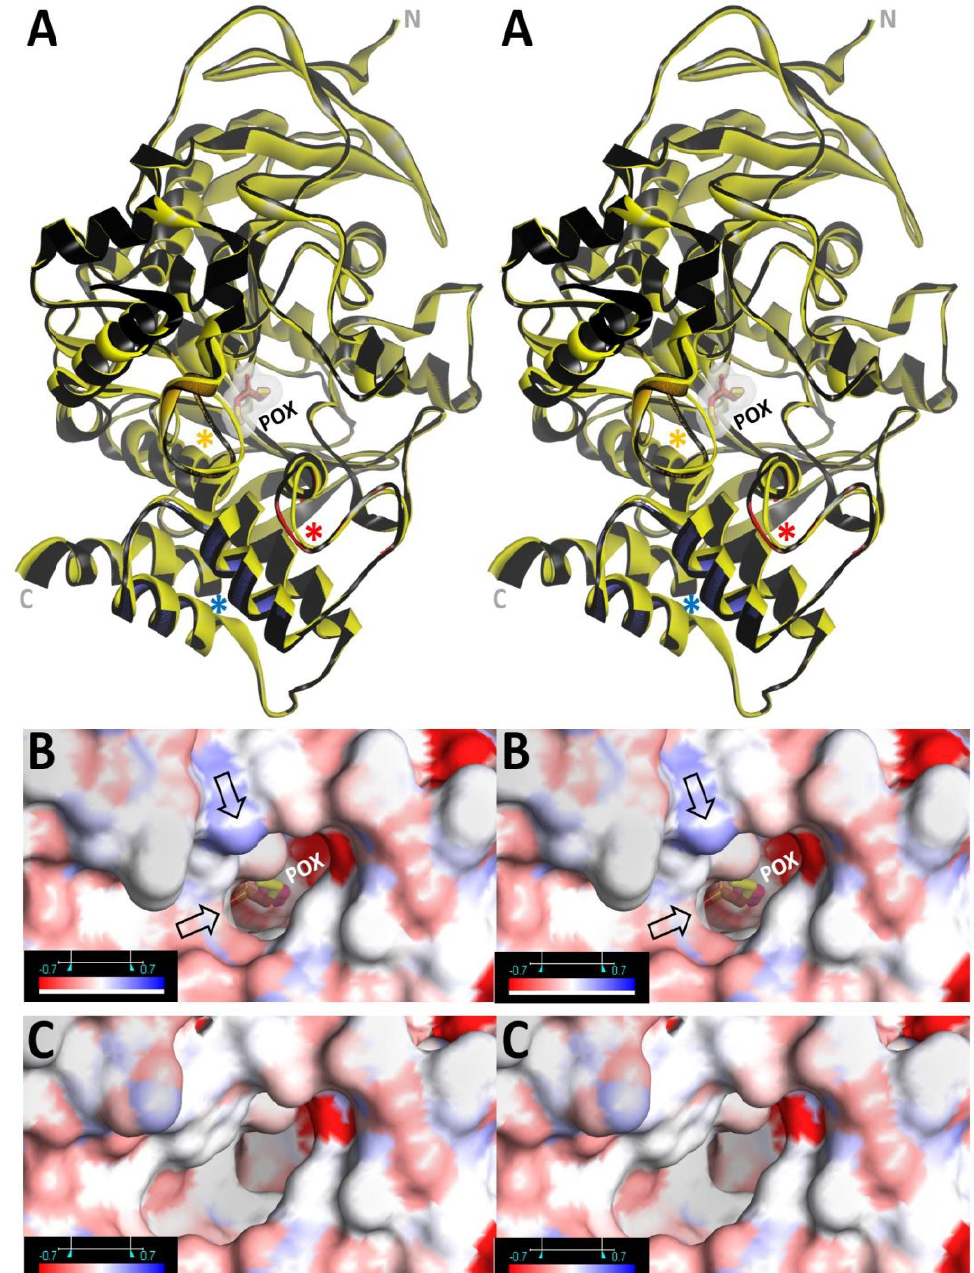
Figure 3. PACCT 3 based overlay of POX-hAChE (Chain A of 5HF5) on Apo-hAChE (Chain A of 4EY4) in stereo. ( A ) Ribbon representation of Cα backbones for POX-hAChE (yellow) and Apo-hAChE (black) with N- and C- terminus labels. Diethylphosphate of POX covalently attached at Ser203 is represented by sticks surrounded with a semi-transparent surface. Asterisks indicate fragments of significant backbone deviation: the acyl pocket loop (orange), and α -helices I (red) and II (blue) in the C- terminal region, as indicated in Figure 4 and summarized in Table 1. ( B ) The influence of the POX-hAChE backbone distortion on the size of the active center gorge opening. Solvent-accessible Connolly surface is colored by atom charge (red-negative, blue-positive). Arrows indicate points of constriction and blue electrostatic barrier imposed by the flipped Arg296 in the AP loop. ( C ) Size of the gorge opening and charge distribution in the Apo-hAChE (4EY4).